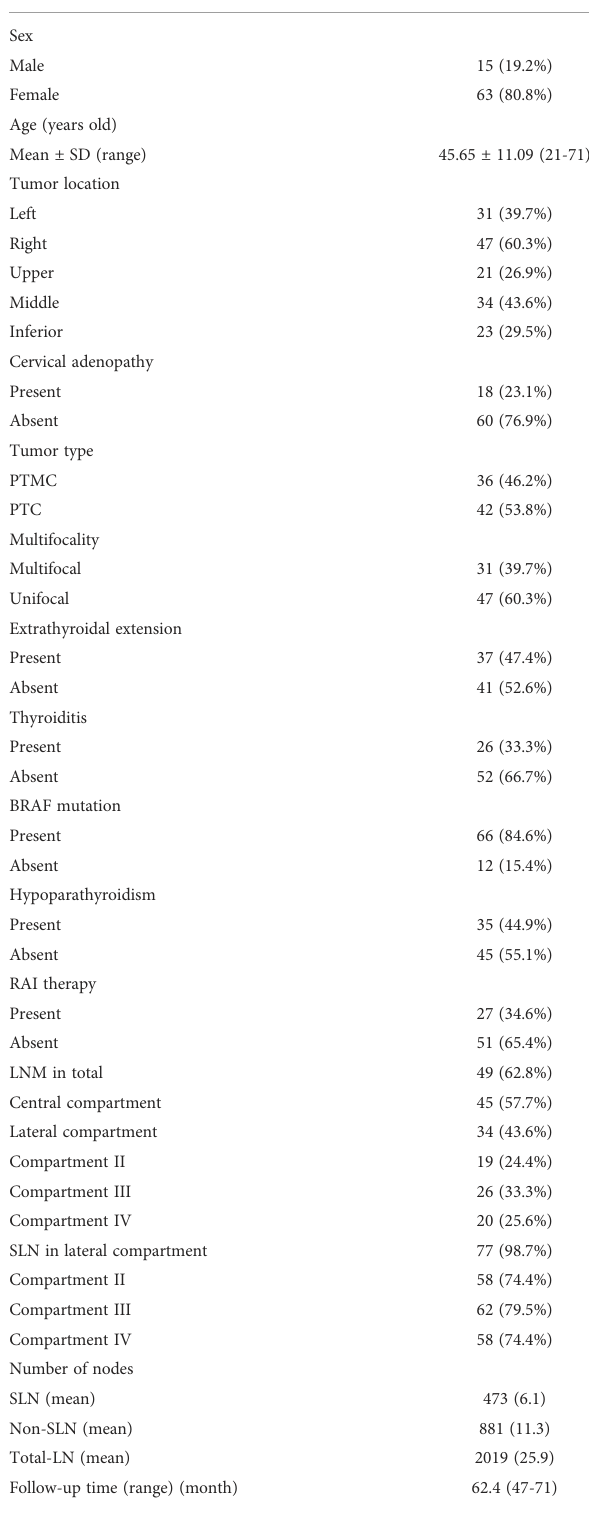
TABLE 1 Patient demographics and tumor characteristics (n =